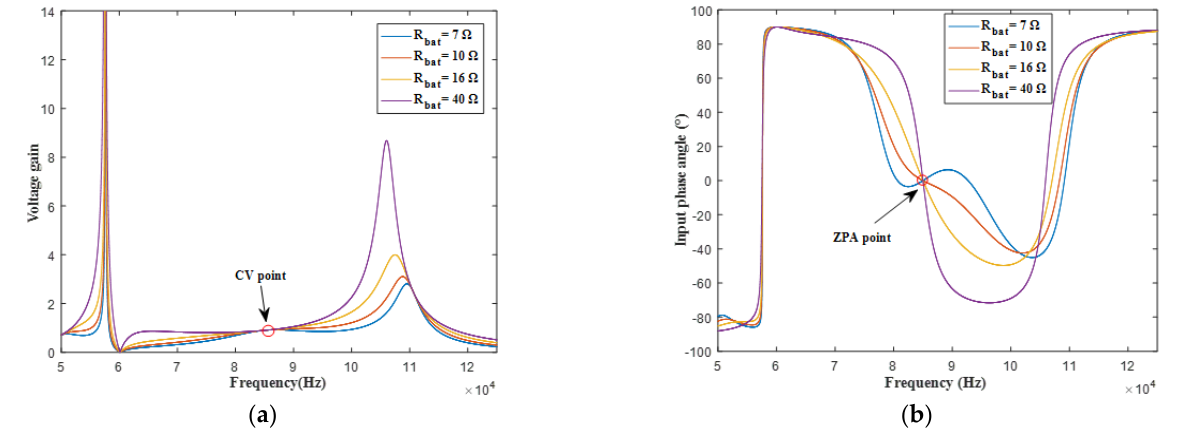
Figure 9. ( a ) Voltage gain of the LCC-S topology and ( b ) phase angle of the input impedance.